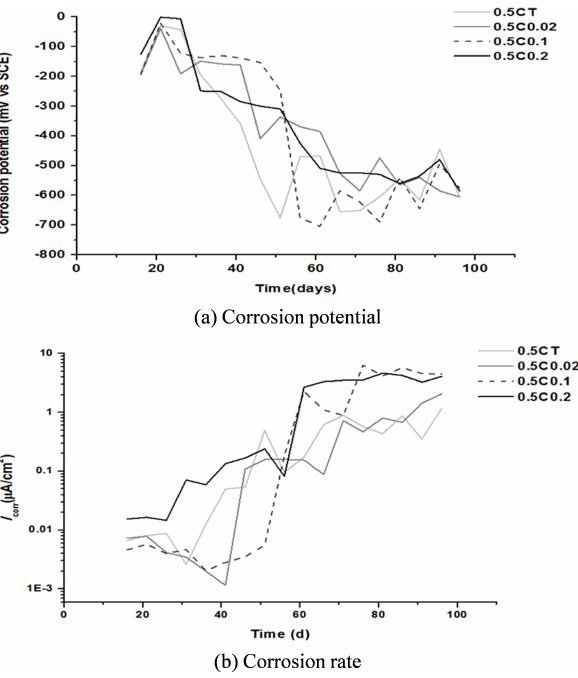
Figure 9: Changes in (a) corrosion potential ( E corr ) and (b) corrosion rate ( I corr ) of steel rebars buried in MWCNTs cement mortar under chloride erosion environment